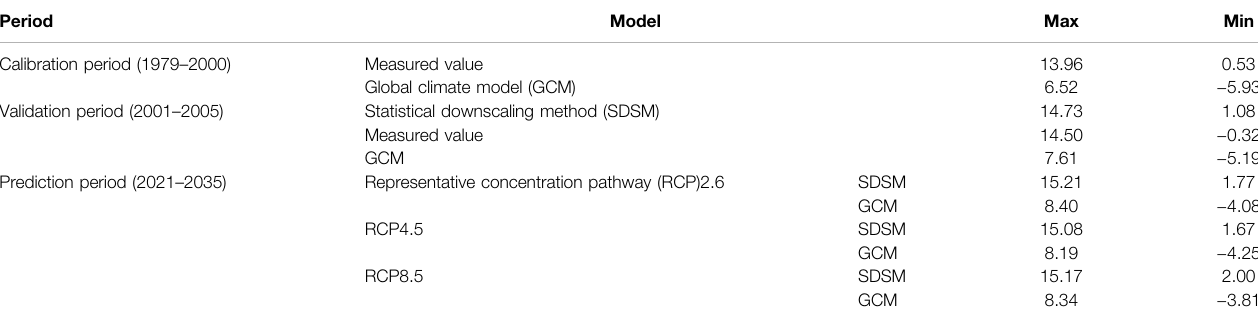
TABLE 2 | The results of daily maximum temperature and minimum temperature in different